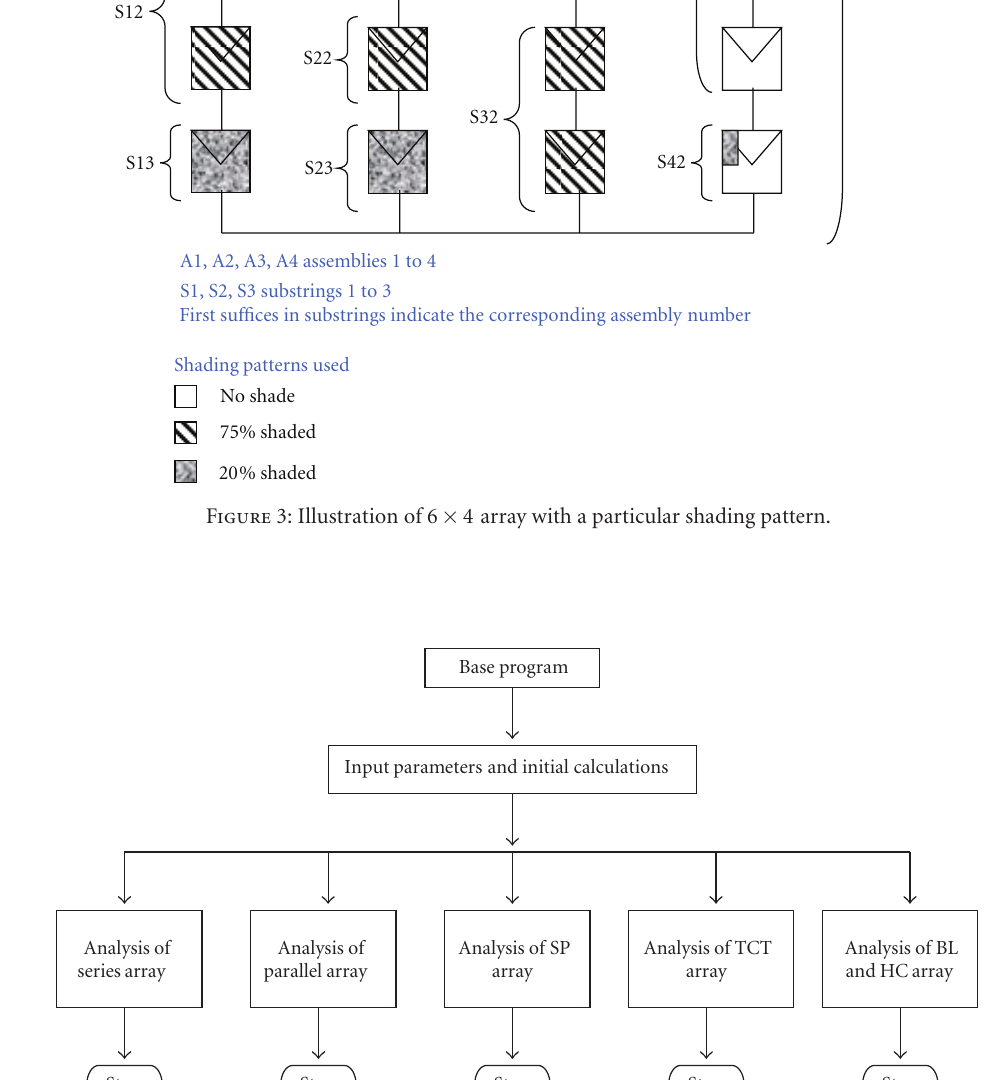
Figure 4: Architecture of the developed